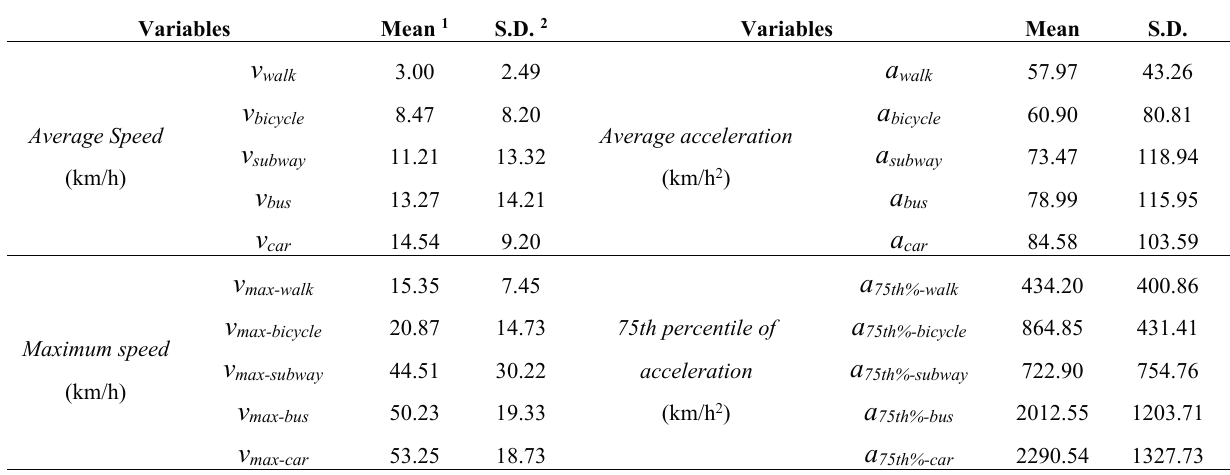
Table 6. Variables in the mode identification